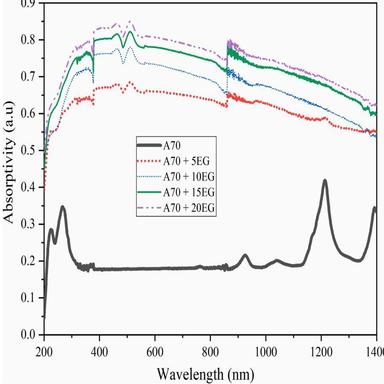
Schematic diagram of absorptivity of base PCM and SS-PCM composites.